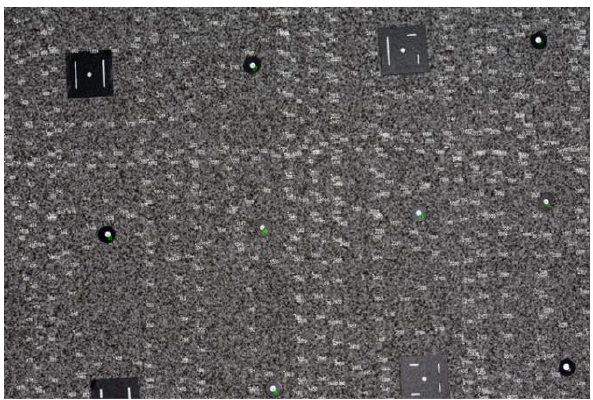
Figure 8. T-probe measurement locations back-projected onto image using photogrammetric lens model.